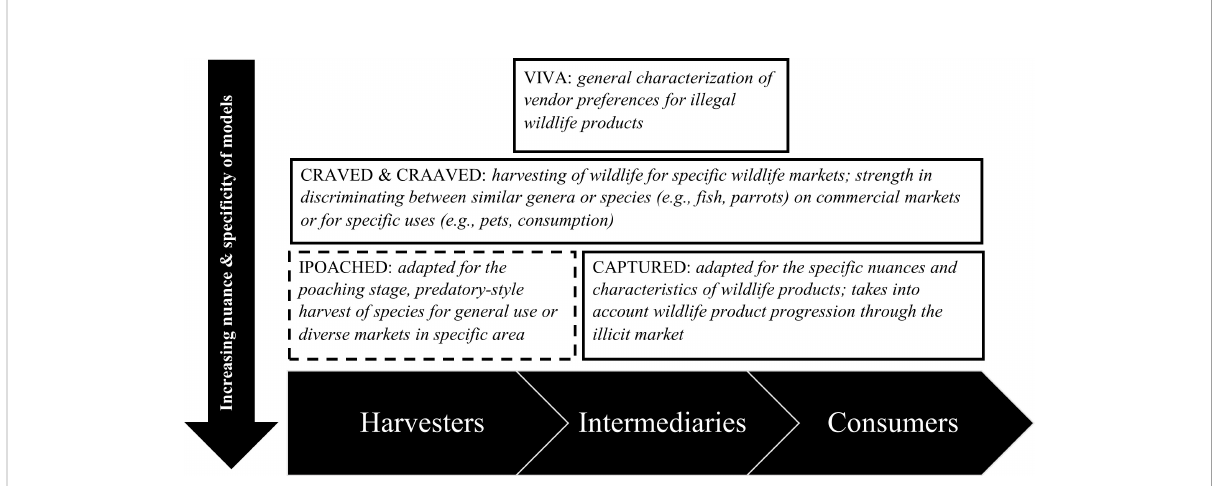
FIGURE 1 Mapping the strengths and uses of various target suitability models in conservation criminology along the illicit supply chain for wildlife species and